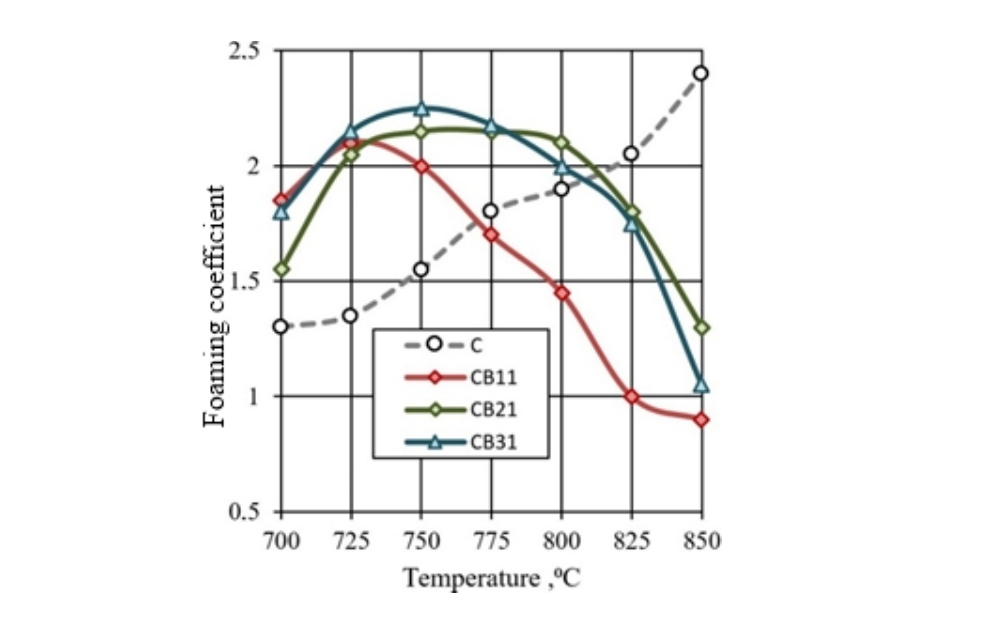
Figure 10. Influence of mixture composition and firing temperature on the granules foaming. Table 4. Influence of the composition of the mixture and the firing temperature on the density of the